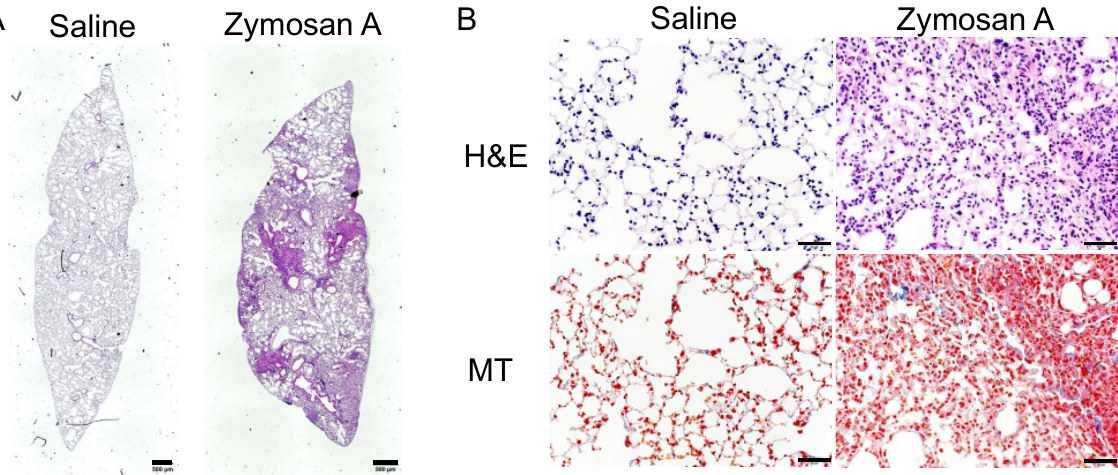
Figure 1. Interstitial lung disease (ILD) induced in SKG/jcl (SKG) mice. ILD was induced in male SKG mice by an intraperitoneal injection of 7.5 mg zymosan A or saline as the control at 8–9 weeks of age. Lung tissue was isolated 12 weeks after the administration of saline or zymosan A and stained with hematoxylin and eosin (H&E) and Masson’s trichrome (MT). ( A ) A representative image of whole area of longitudinal H&E section of the lung from SKG mice administered saline or zymosan A at × 40 magnification. Scale bars indicate 500 μ m. ( B ) Images of H&E (upper panels) or MT (lower panels) staining at × 200 magnification. Scale bars indicate 50 μ m.